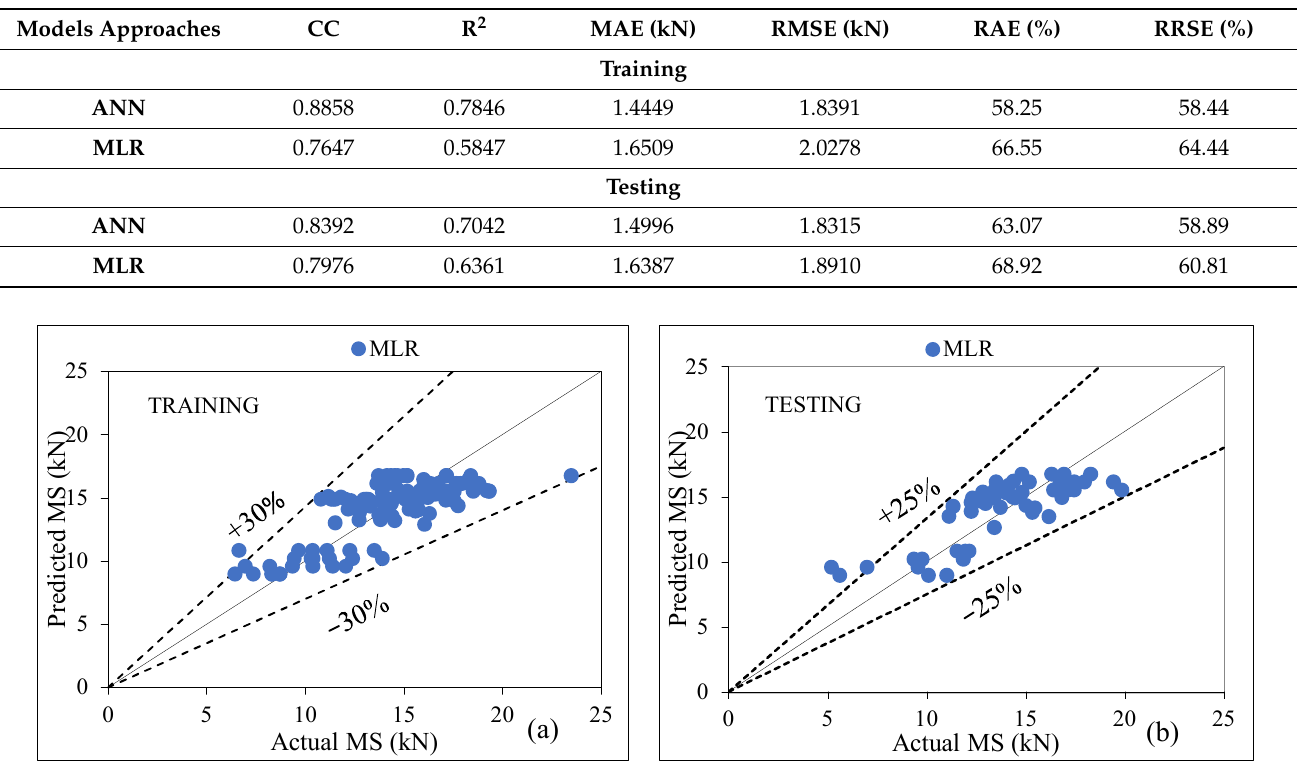
Figure 9. (a , b ) Agreement graph showing actual vs. predicted values of MS by using an MLR model for both stages.